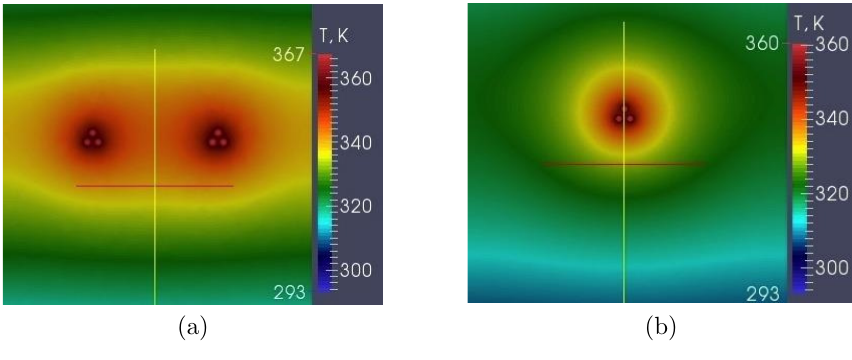
Figure 5. Simulation results for trefoil cables: (a) electrical current I = 609 A, (b) I = 675 A. Determination of the maximal electrical current value. In